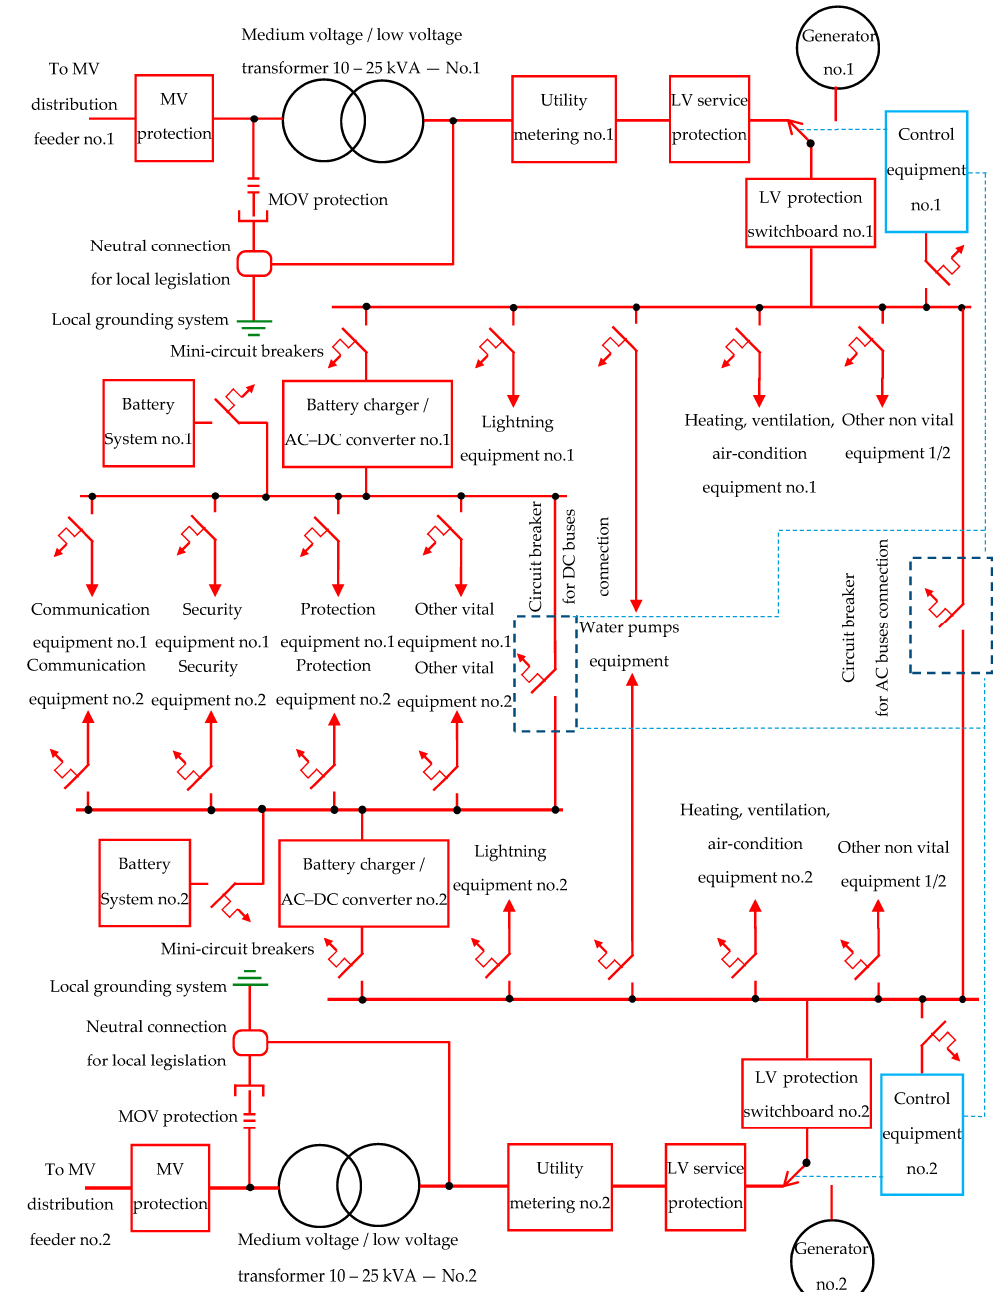
Figure 3. Proposed typical single line diagram of the auxiliary power IT system supplied by the medium voltage distribution system with high reliability requirements.